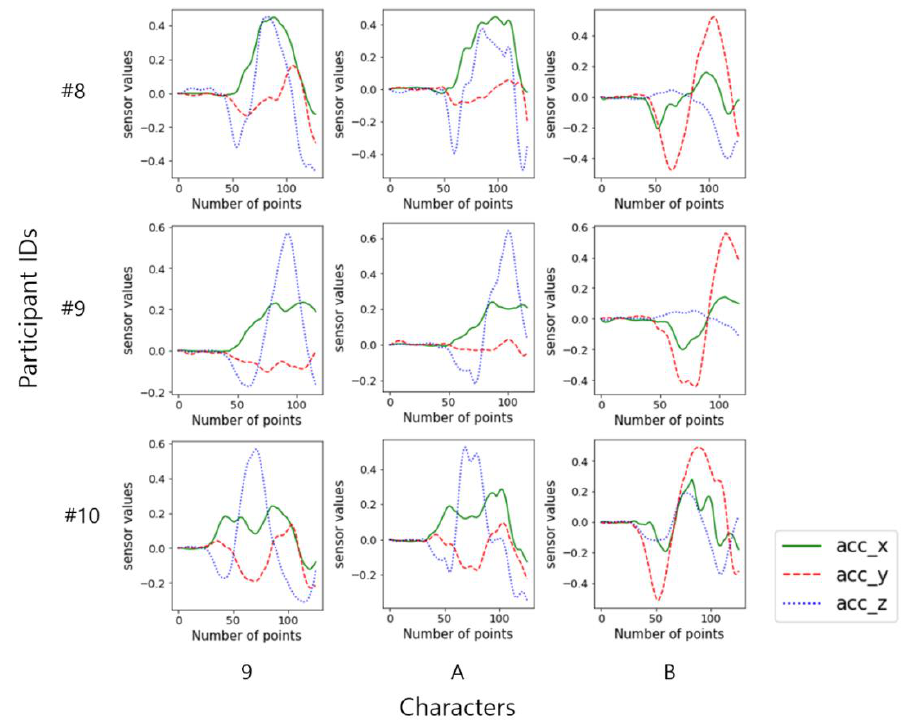
Figure 6. Acceleration signals of three characters by three participants.